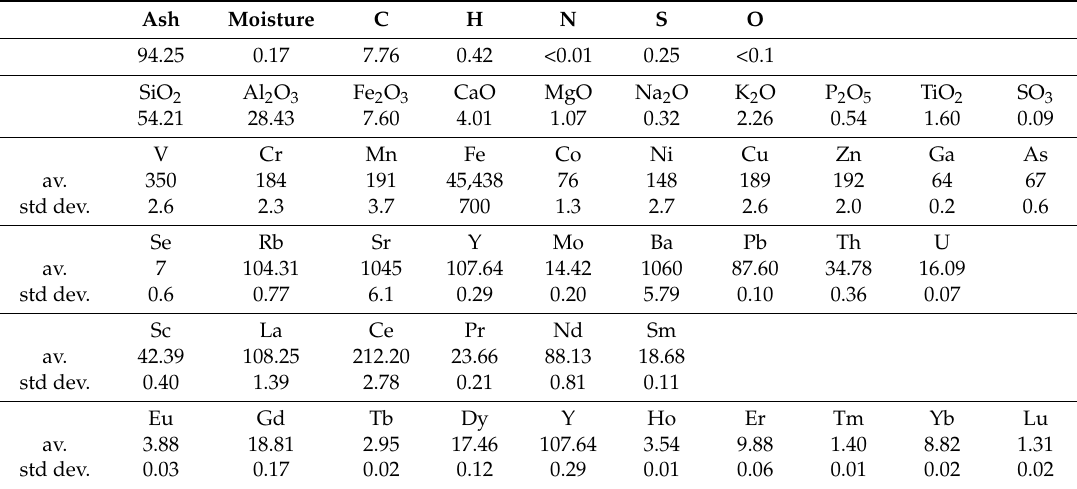
Gd Tb Y Ho Tm Yb Lu